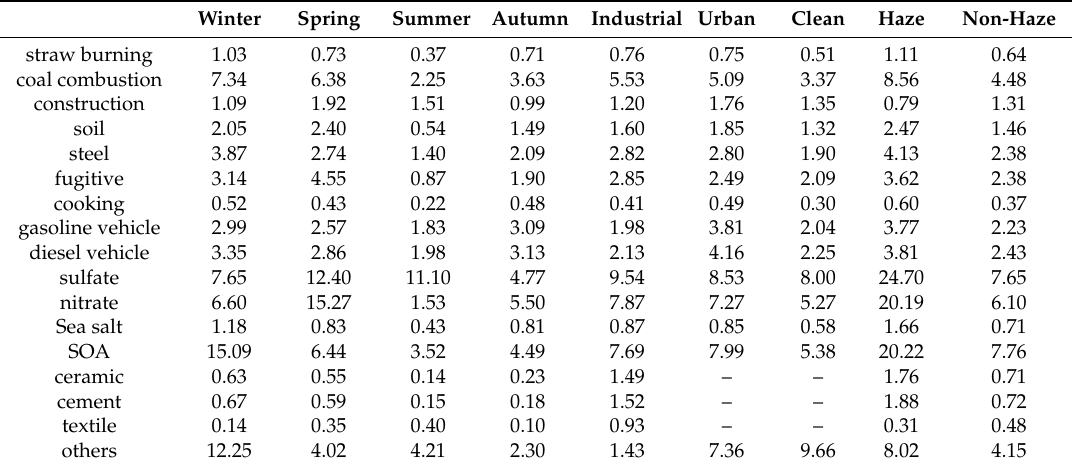
Table 3. Average source contribution estimates (SCEs) of PM 2.5 mass concentrations using chemical mass balance (CMB) models ( µ g/m 3